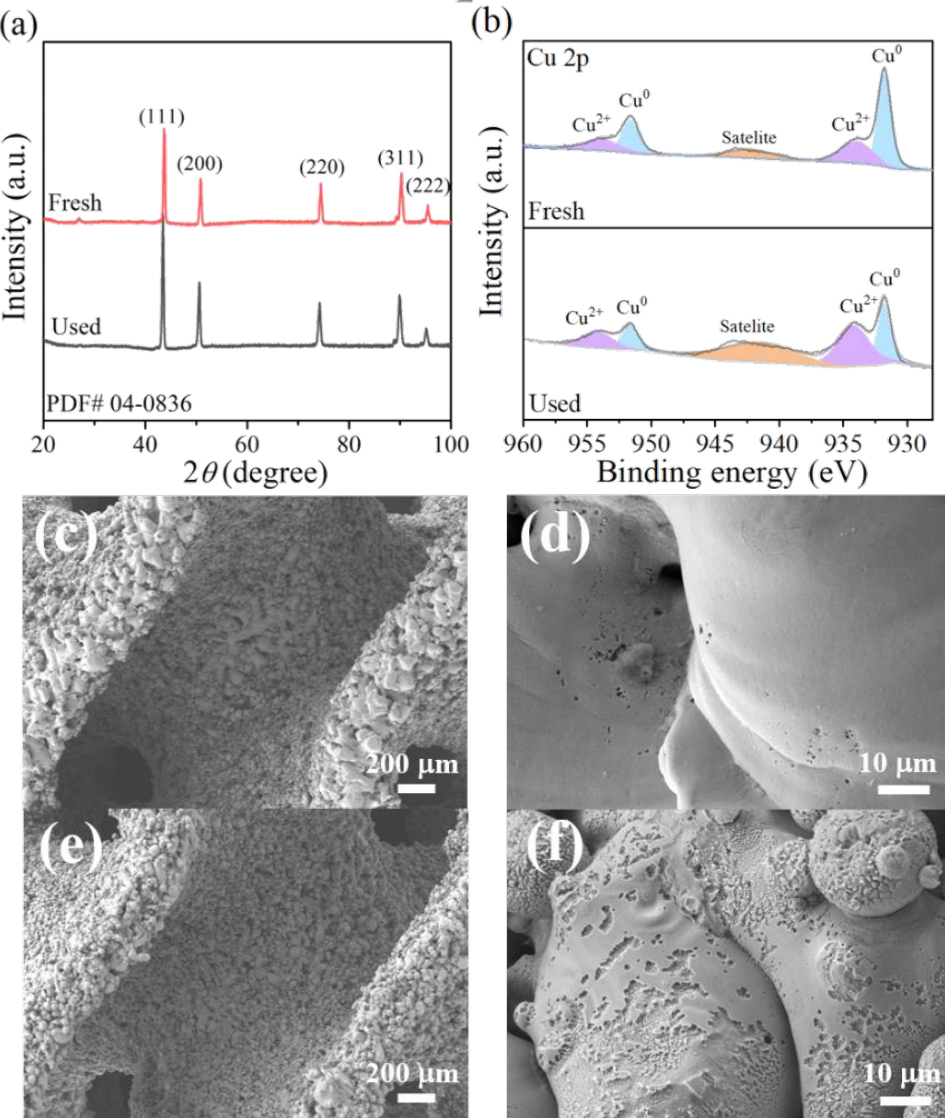
Figure 1. ( a ) XRD patterns of 3DHP-ZVC, ( b ) Cu 2p XPS spectra of 3DHP-ZVC before and after reactions, and SEM images of ( c – d ) 3DHP-ZVC, and ( e – f ) used 3DHP-ZVC. reactions, and SEM images of ( c , d ) 3DHP-ZVC, and ( e , f ) used